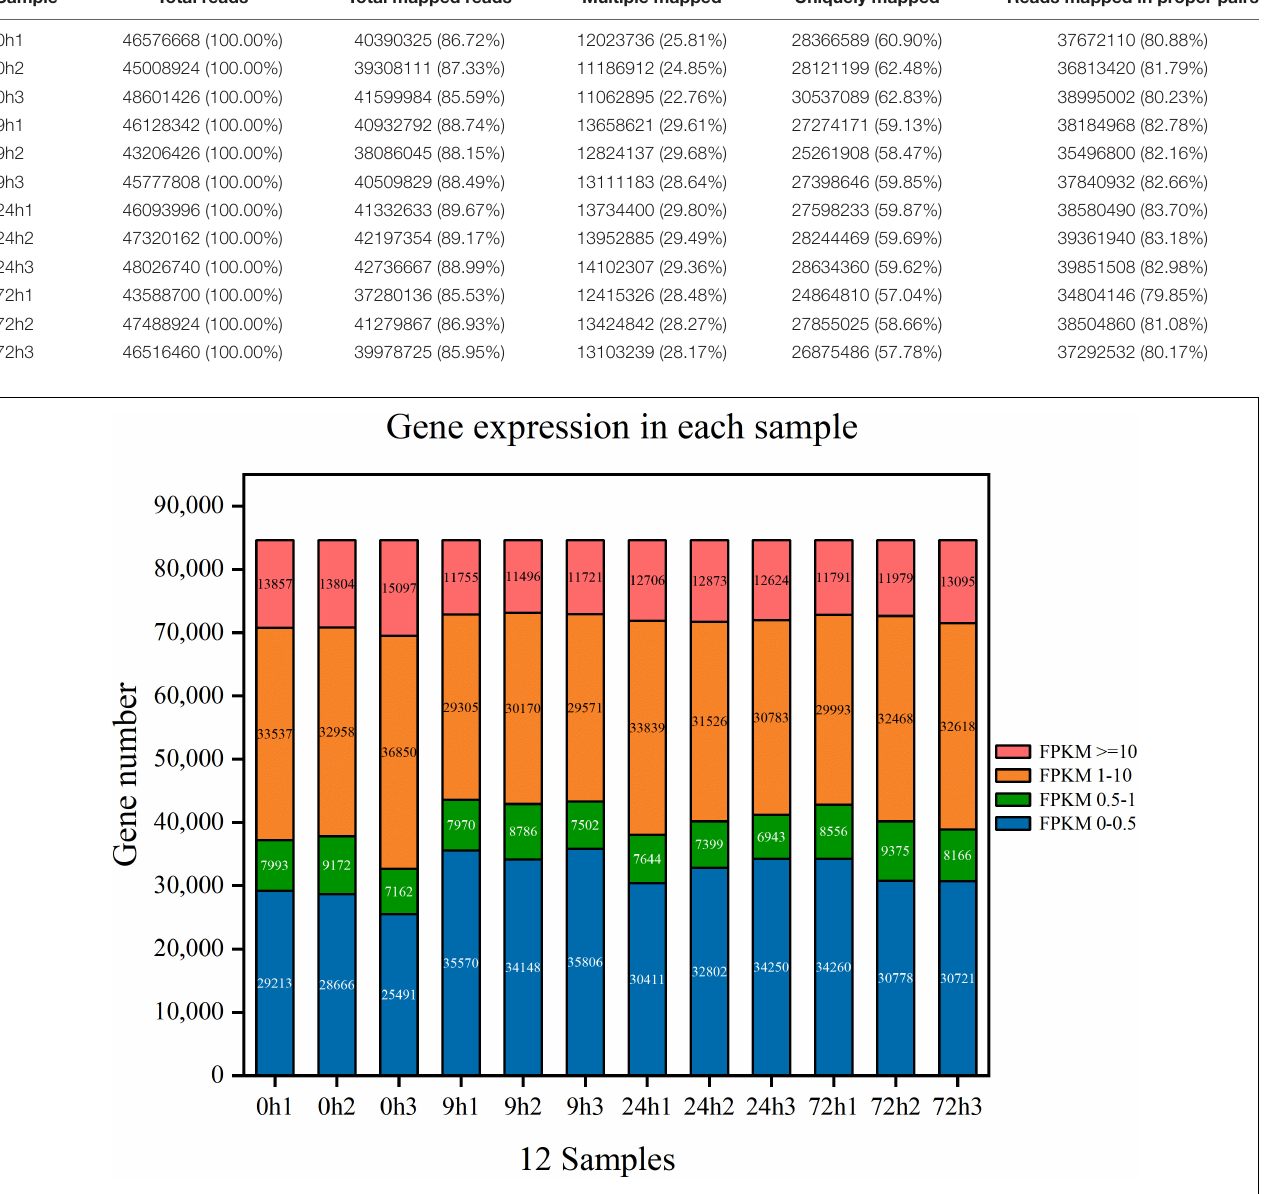
FIGURE 2 | Gene expression in each sample of Styrax tonkinensis seedlings under waterlogging stress after 0, 9, 24, and 72 h, respectively. Different colors in the figure represent different ranges of FPKM values. The horizontal axis is each sample, and the vertical axis is the number of protein-coding